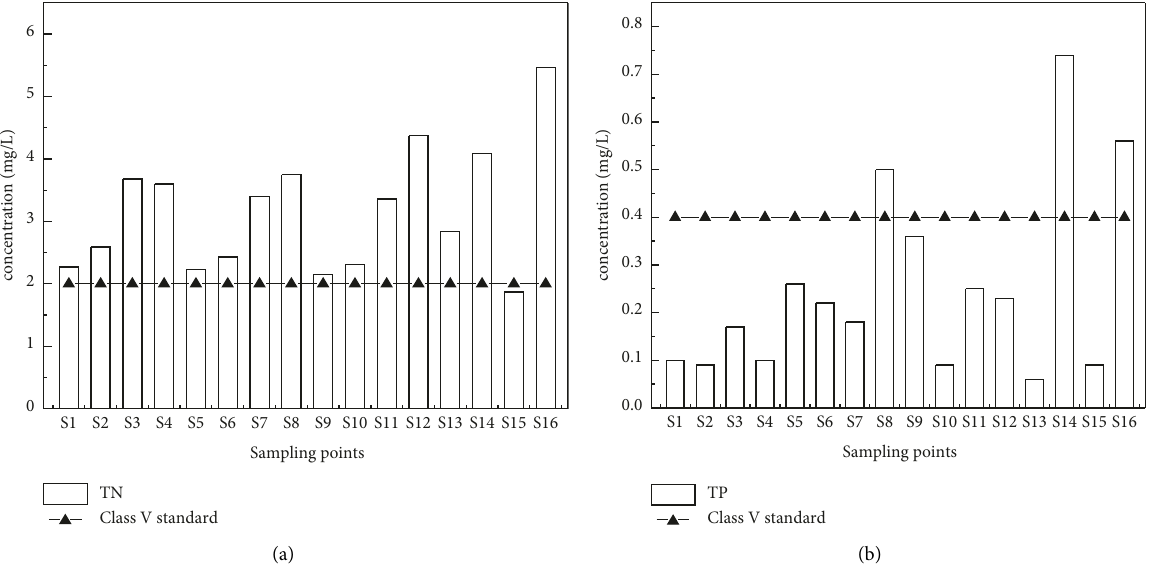
Figure 2: The content of TN (a) and TP (b) at each sampling point in the Huainan coal mining subsidence water